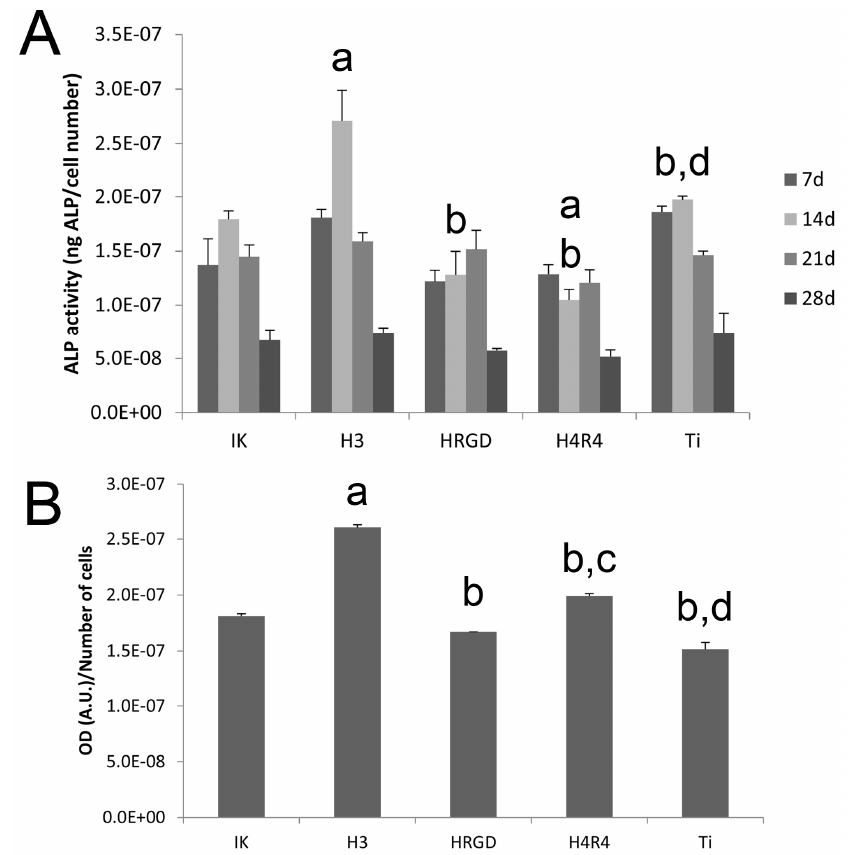
Figure 9. Cell differentiation: ALP activity at 7, 14, 21, and 28 days ( A ) and quantification of calcium deposits at 28 days ( B ) of rMSCs cultured on the different functionalized and non-functionalized (Ti) scaffolds. At each time point, “a” indicates statistically significant differences compared to IK, “b” indicates statistically significant differences compared to H3, “c” indicates statistically significant differences compared to HRGD, and “d” indicates statistically significant differences compared to H4R4.